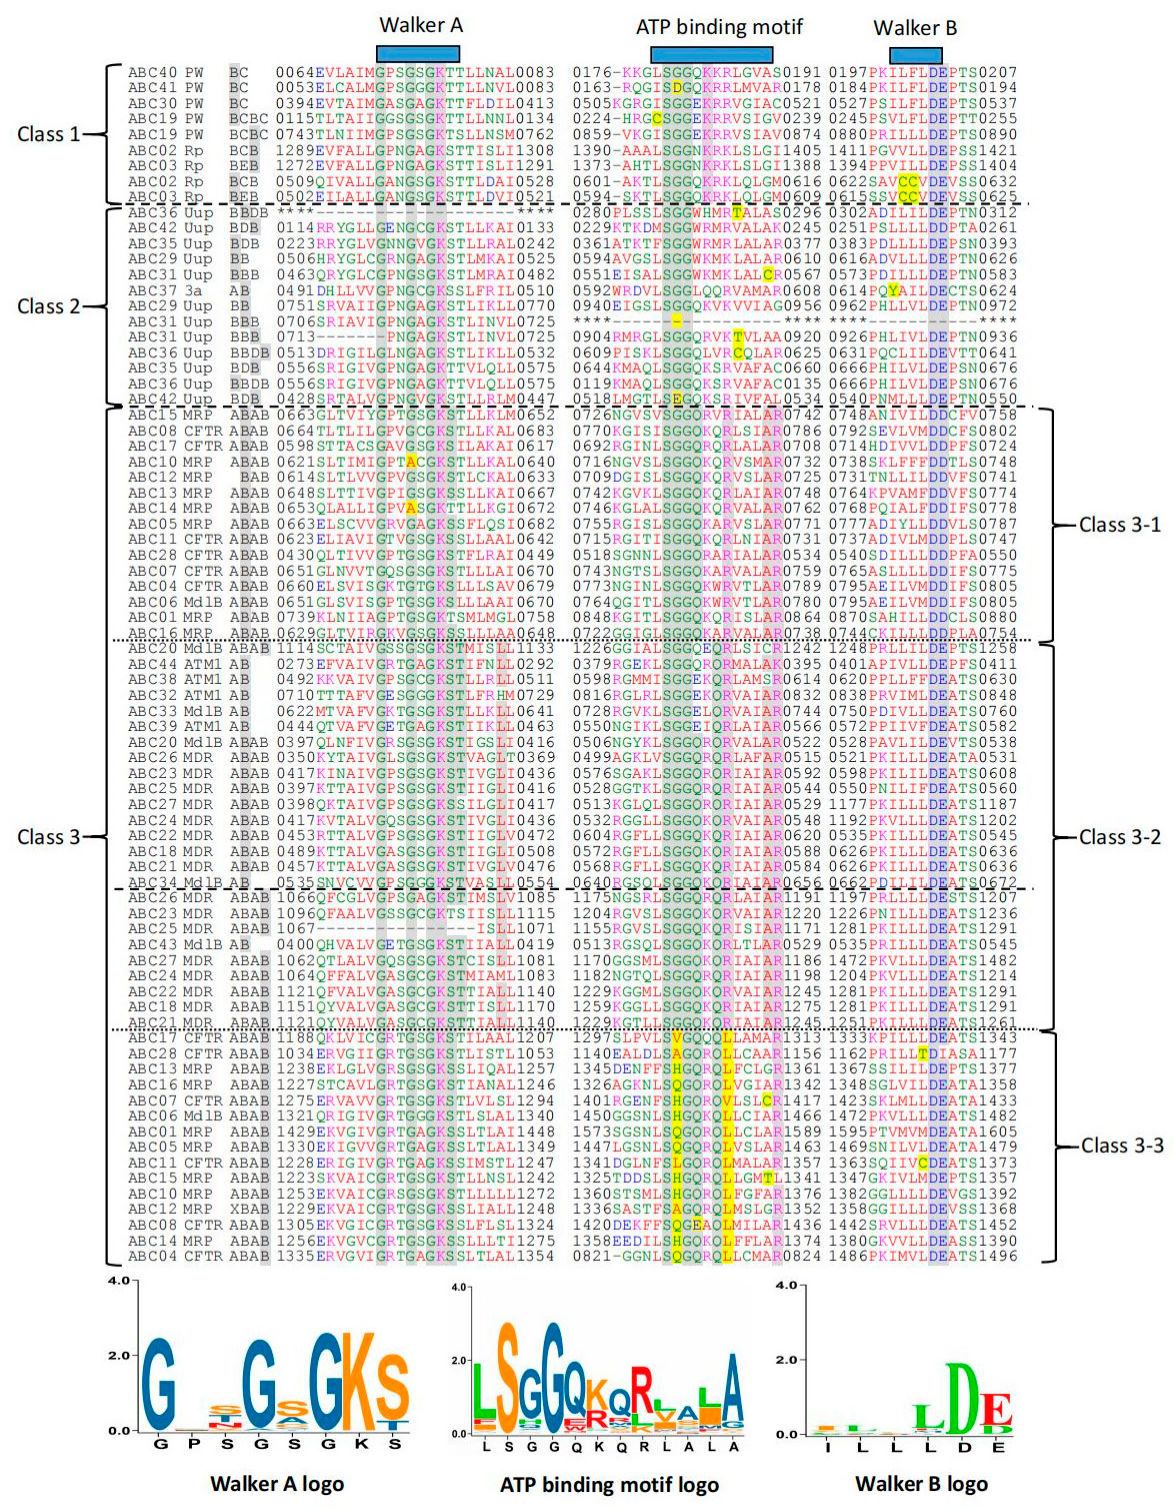
Figure 1. Alignment of the 79 NBDs within the 44 ABCs. NBDs were predicted using NCBI BlastP, and amino acid sequences that differ from previous studies are highlighted in yellow. Numbers in names indicate the ABC protein number. The B with the shadow in the names represent the NBD and the position of the peptide.